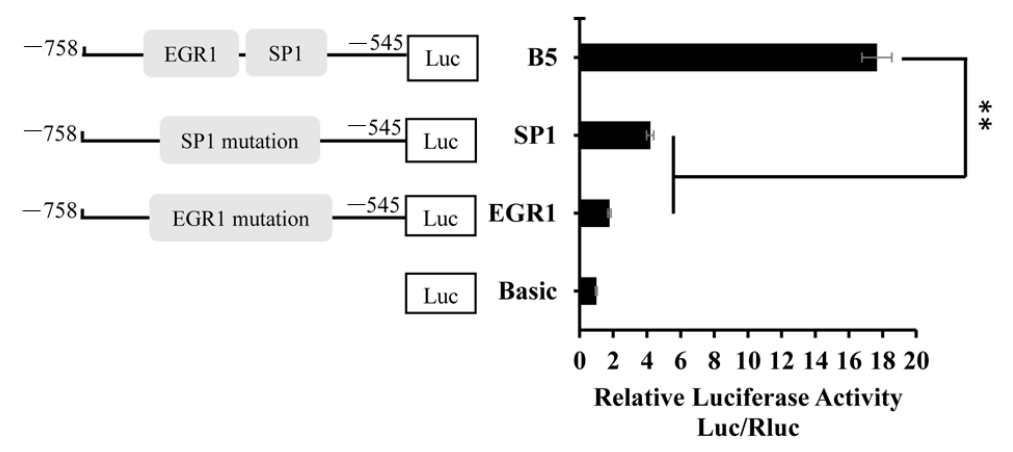
Figure 5. Point mutation analysis of EGR1 and SP1. Note that the binding sites of EGR1 and SP1 were in the B5 fragment. SP1 : the SP1 mutation. EGR1 : the EGR1 mutation. The marker “**” represents a highly significant difference ( p < 0.01).